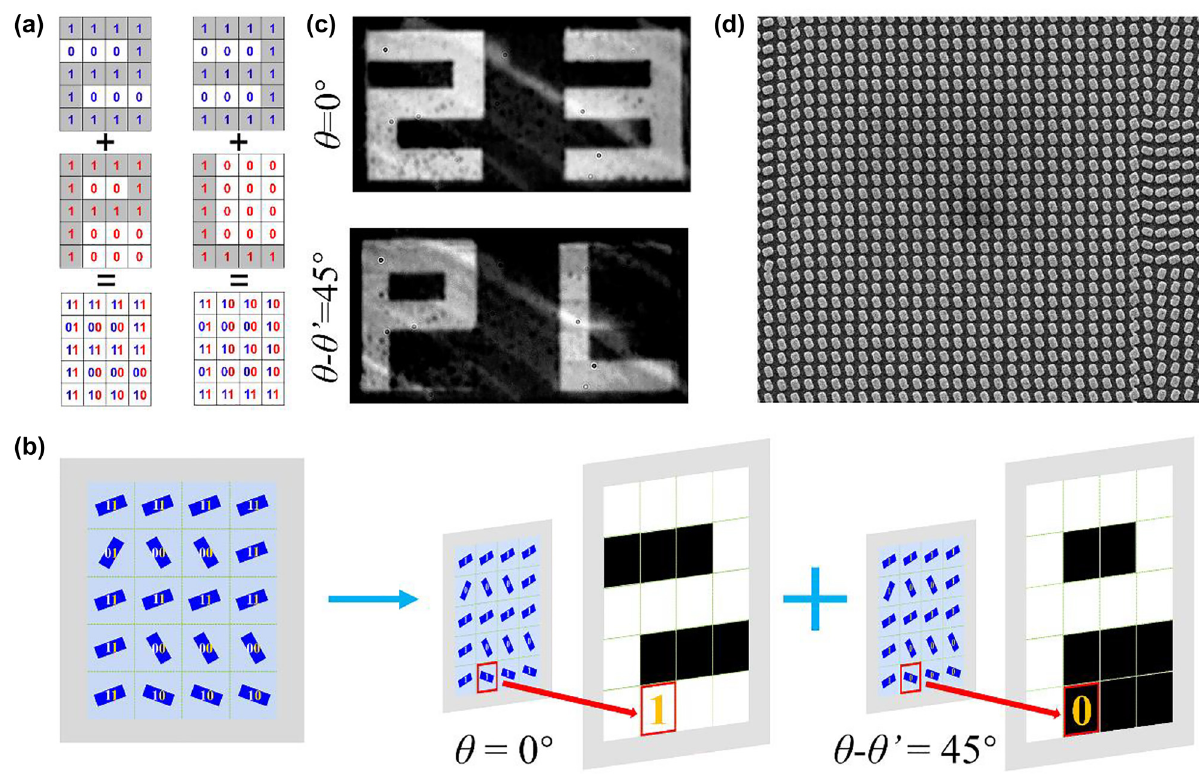
Figure 3: Schematic and experimental demonstration of the polarization encoded display metasurface. (a) The design approach of polarization encoded display. (b) The selection principle of orientation angles of nanorods for polarization encoded metasurface. (c) Measured optical images of polarization encoded metasurface at differently polarized incidences. (d) SEM image of polarization encoded metasurface composed of the unit cell structure of